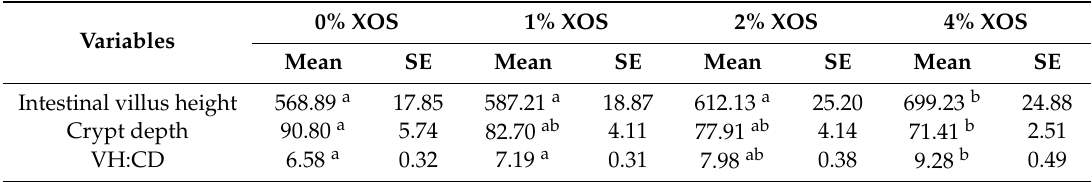
Table 4. Duodenum morphological measurement of 58-d mice fed di ff erent levels of XOS (Mean values and standard errors; n = 8 in each group).